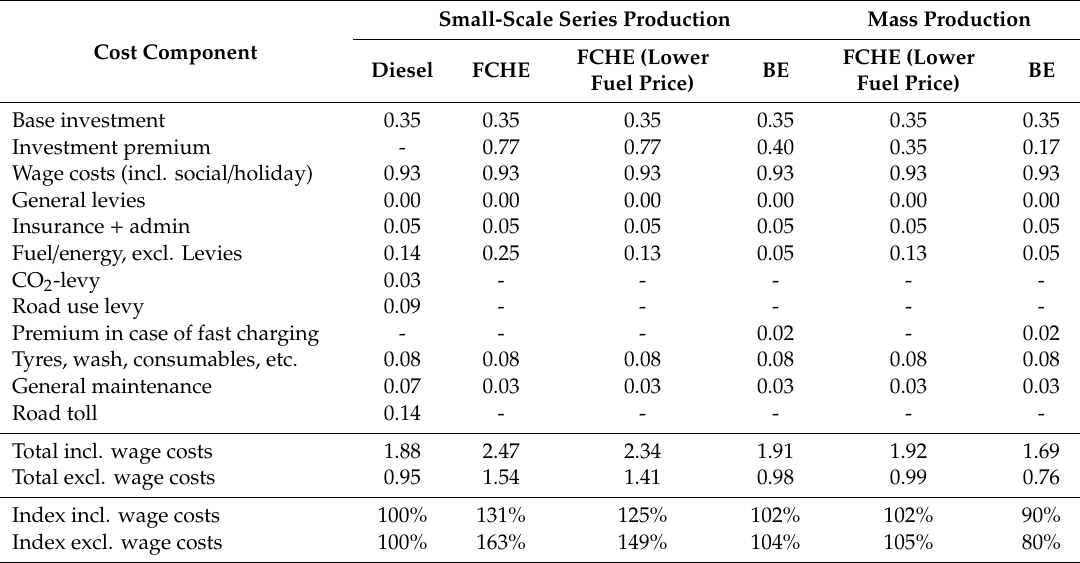
Table 5. Decomposed ownership costs for light distribution trucks. For small-scale series production with current and reduced hydrogen (fuel) prices, and for mass production. Figures in EUR / km. Costs are based on a period of analysis of 5 years and annual mileages of 45,000